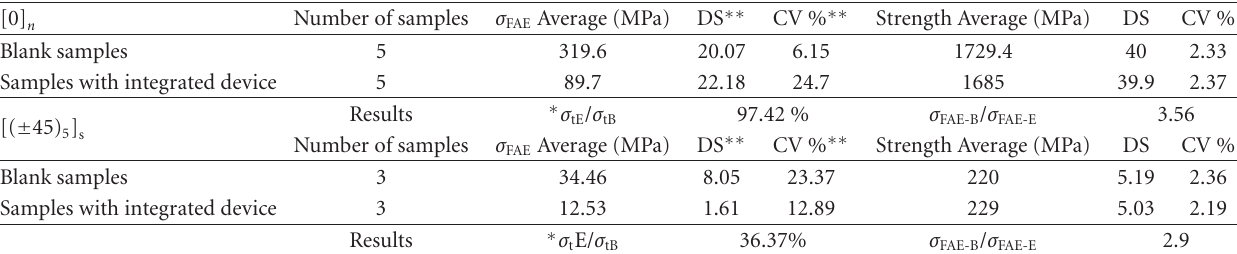
Table 5: Material with and without integrated inclusions: stress, amplitude, and frequency range of the first acoustic events, and their classification. The lower and upper limits of each range are the lower and upper values observed among all the experiments conducted. Only the events in a stress window of about 20 MPa have been considered. Results from [0]